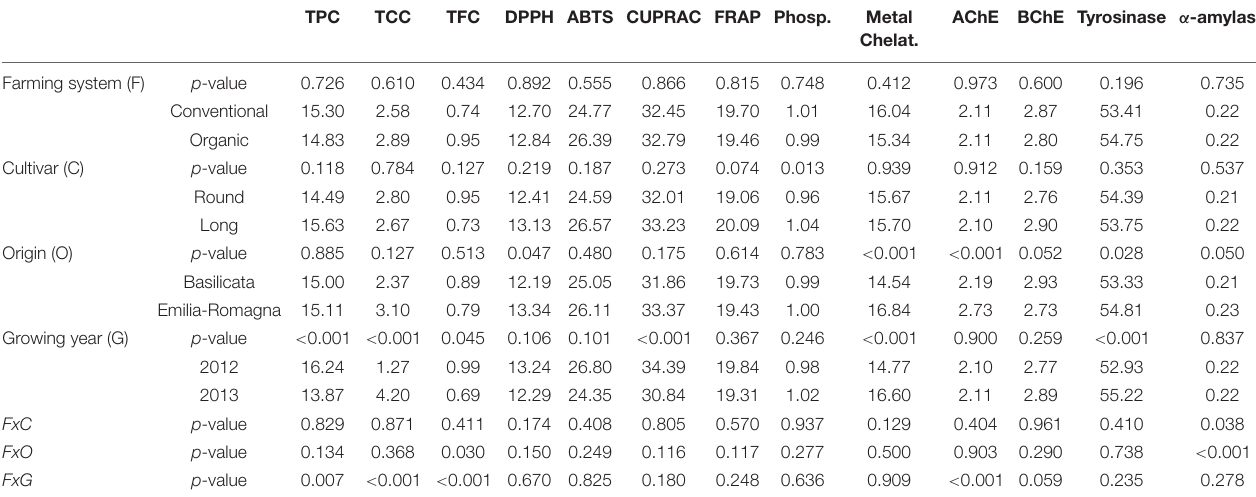
TABLE 2 | Effect of the farming system (F), cultivar (C), origin (O), and growing year (G) on the phenolic and carotenoid contents, antioxidant activities and inhibitory activities of the different tomato samples, expressed as mg/g of dry weight. TPC TCC TFC DPPH ABTS CUPRAC FRAP Phosp. Metal